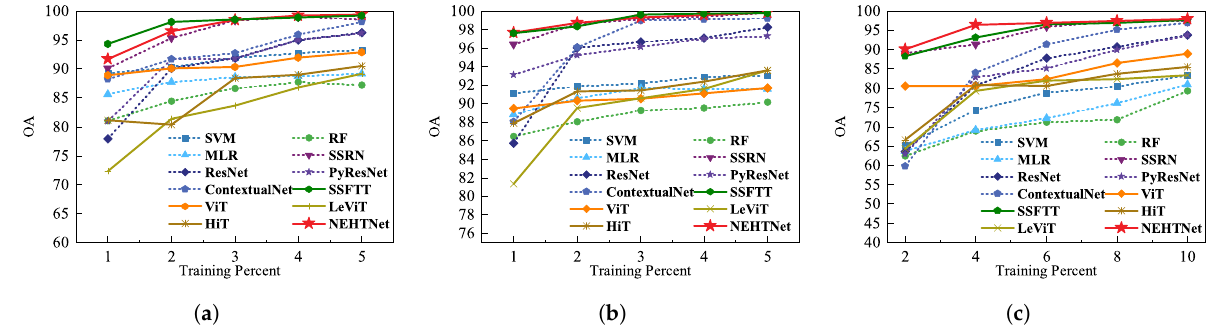
Figure 11. OA(%) with different training rate with 1%, 2%, 3%, 4% and 5% for ( a ) PU and ( b ) SA data sets.2%, 4%, 6%, 8% and 10% for ( c ) IP data